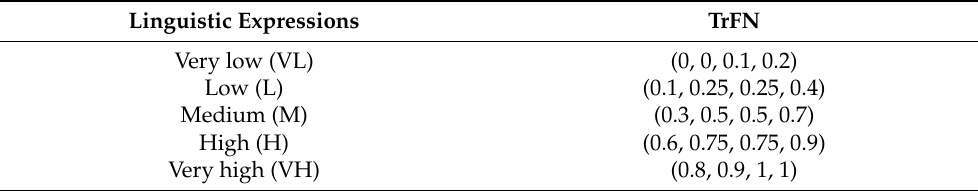
Table 1. Linguistic expressions and corresponding TrFN. Linguistic